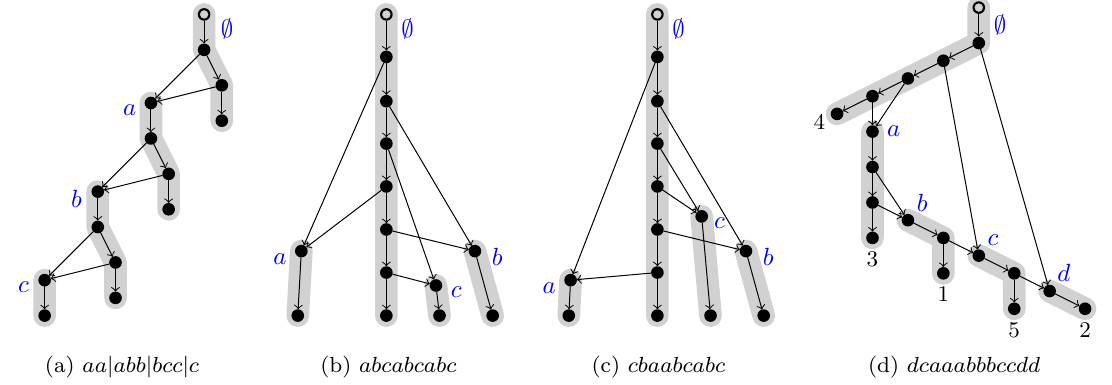
Figure 2. Some encodings of Maximally Reticulated Tree-Child Networks . In panel ( a ) bars have been used to explicitly delimitate the path-components. As explained in the Proof of Proposition 2, the bars can be discarded without losing